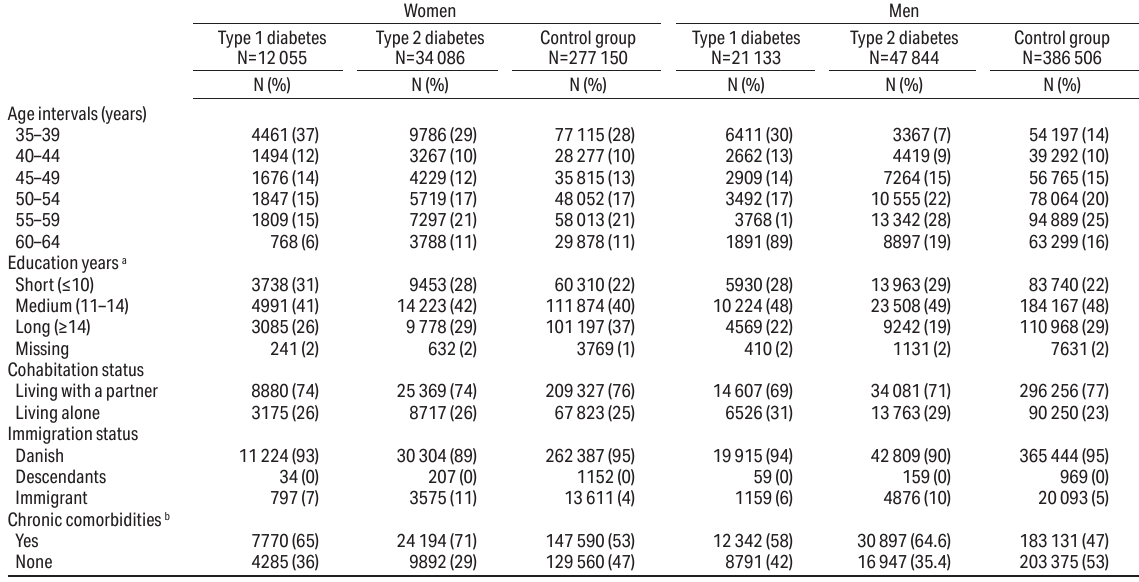
Table 1. Population